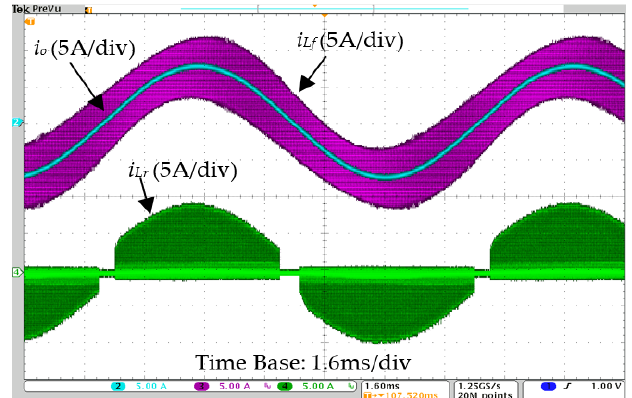
Figure 18. Experimental waveforms of the auxiliary current with an 8 A, 100 Hz sinusoidal output current.